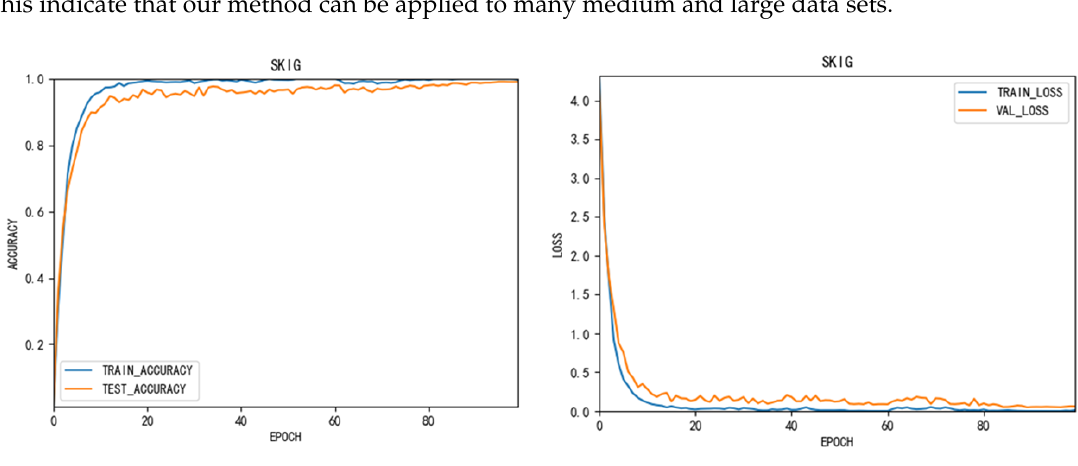
Figure 6. Accuracy on SKIG dataset using MEMP